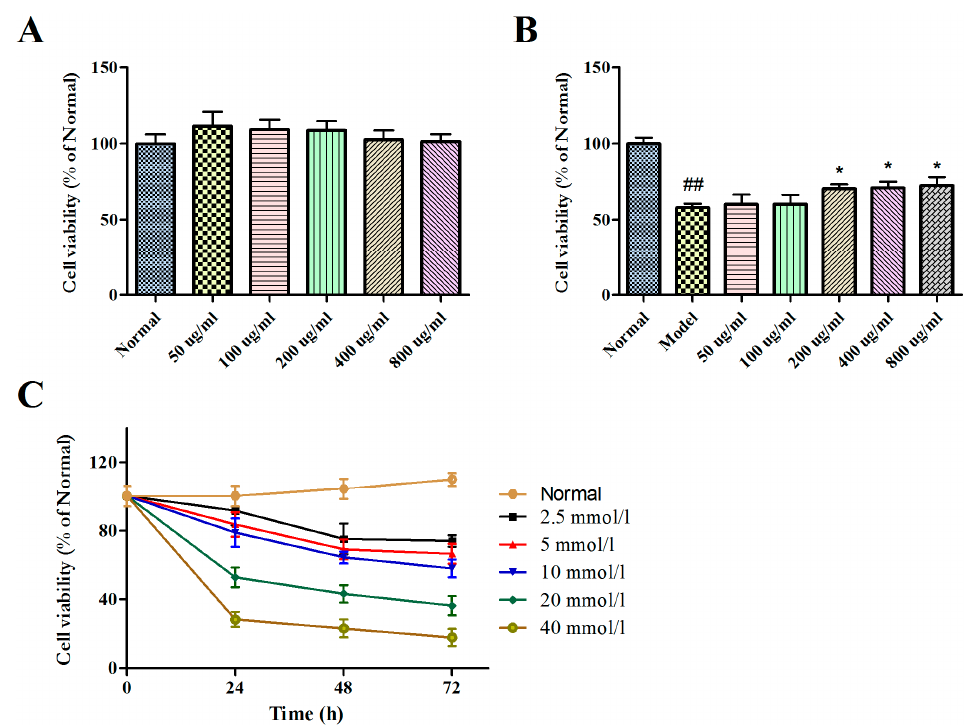
Figure 1. Protective effects of BBPs on the cell viability of NGF-induced PC12 cells injured by Glu. ( A ) The e ff ect of BBPs at di ff erent concentrations on the cell viabilities of NGF-induced PC12 cells. ( B ) The e ff ects of BBPs on the cell viability of NGF-induced PC12 cells stimulated by Glu. ( C ) The e ff ects of Glu at di ff erent concentrations on the cell viabilities of NGF-induced PC12 cells. Normal group: NGF-induced cells without BBPs and Glu; Model group: NGF-induced cells without